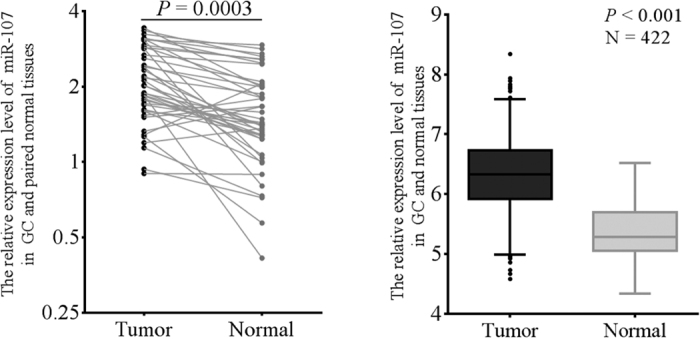
The difference of miR-107 expression between the gastric carcinoma and paired corresponding non-cancerous tissues.(A) The expression of miR-107 in 55 paired of gastric carcinoma and corresponding normal tissues. (B) The expression of miR-107 in TCGA (n = 422).